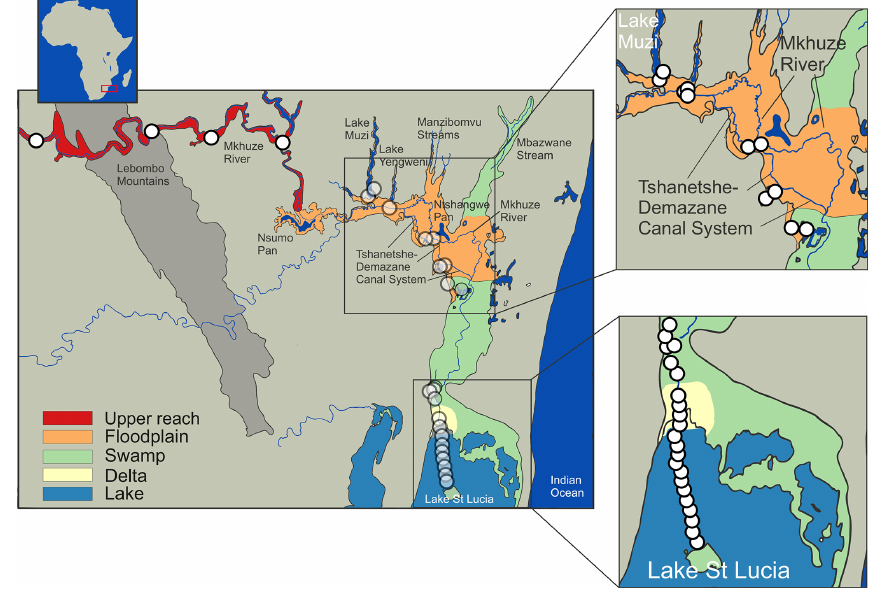
Figure 1. Map of the Mkhuze catchment area. White circles represent sampling locations, and colored areas refer to the assigned sub- environments. Important geologic features, including watercourses and major lakes or pans, are named.